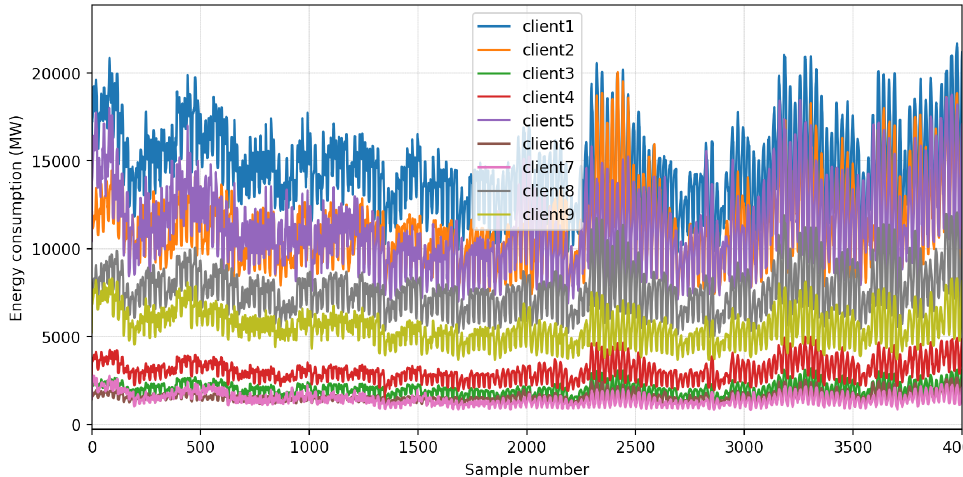
Figure 2. A sample of the data set.